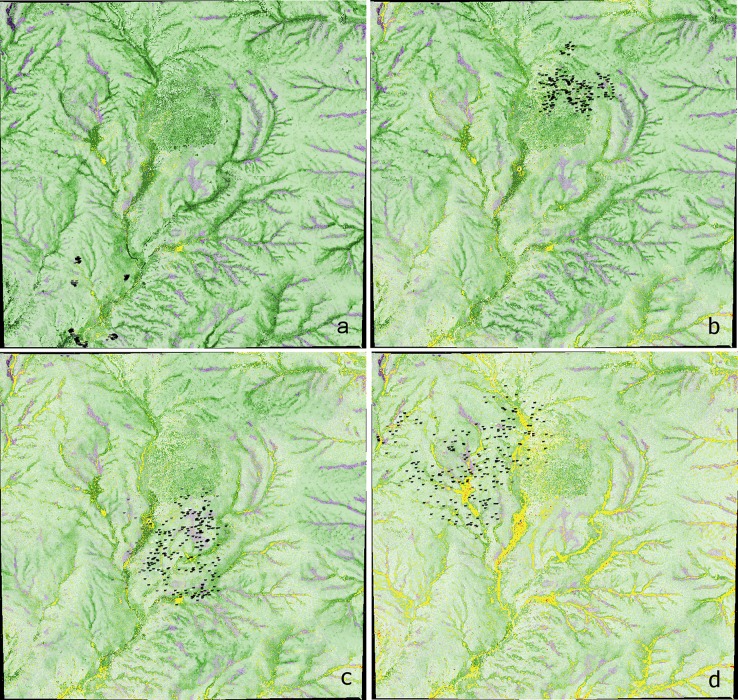
The effect of varying herd-cohesion-factor (HCF) on herd patterns, displayed at different levels of pasture usage (AUMs).Note that the cows depicted in these images are drawn 200 times larger than they really are to aid visualization, which makes them appear closer to one another than they are. Pasture size is 1.66 km x 1.58 km, and stocking density for all images is 1.0 AU • ha-1. White cows are leaders, black followers, and gray independents. Yellow indicates patches that have been grazed twice, red three times. (a) HCF = 10, AUMs = 14; (b) HCF = 7, AUMs = 68; (c) HCF = 4, AUMs = 119; (d) HCF = 1, AUMs = 163. Typical usage for this pasture (258.82 ha) is 150 AUMs.